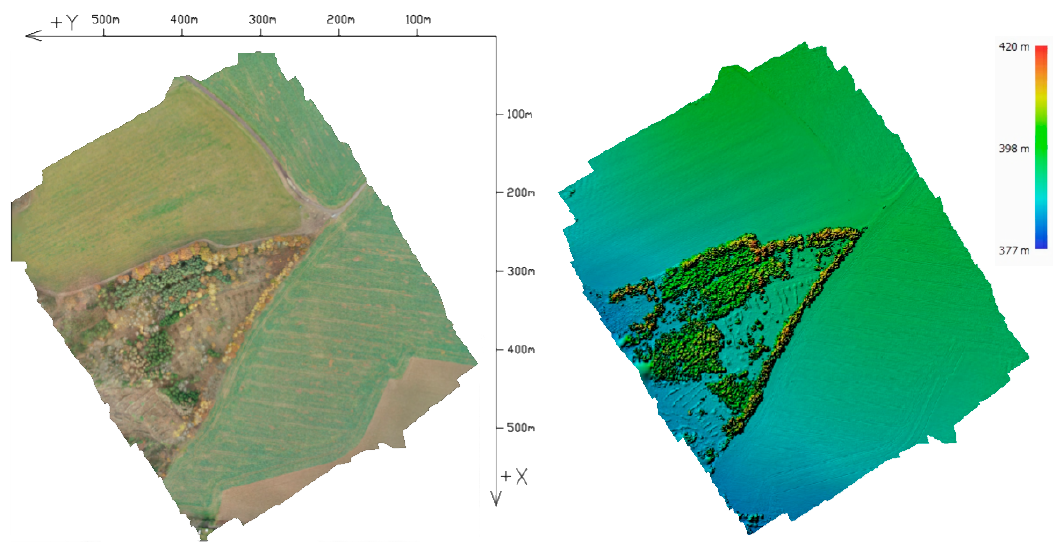
Figure 1. Urban area: orthophoto and DEM (Digital Elevation Model).